Question: Which kind of chart has been used to present this data?
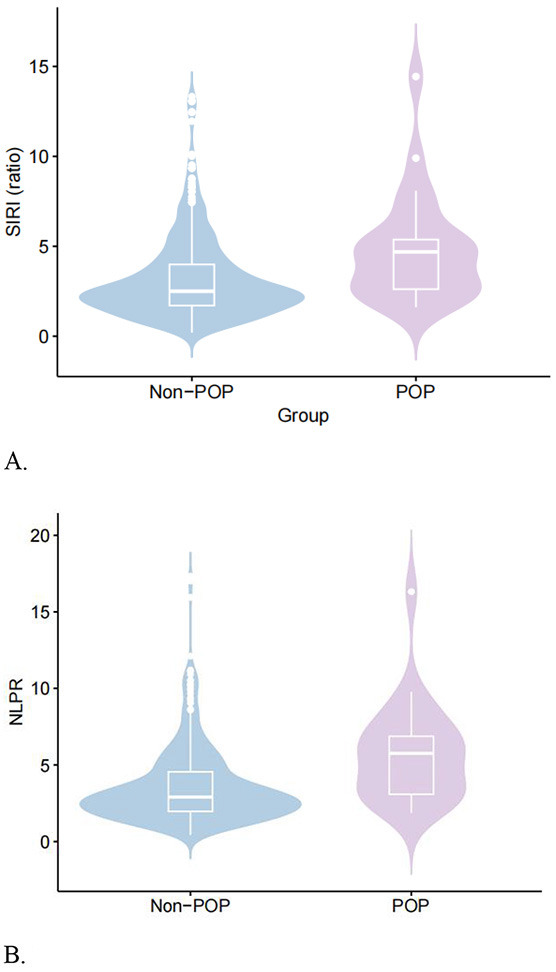
Answer: box